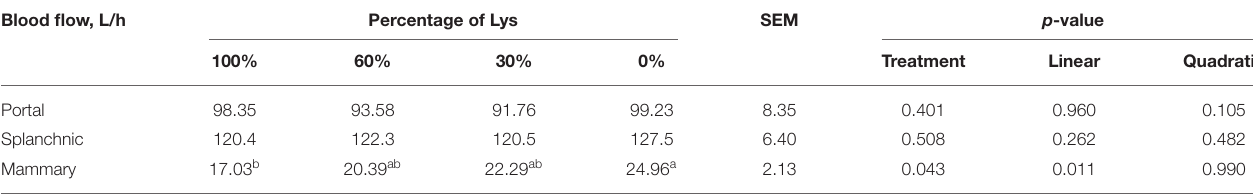
TABLE 6 | Effects of graded removal of Lys from the AA mixture infused into abomasum on splanchnic blood flows in lactating goats. Blood flow,